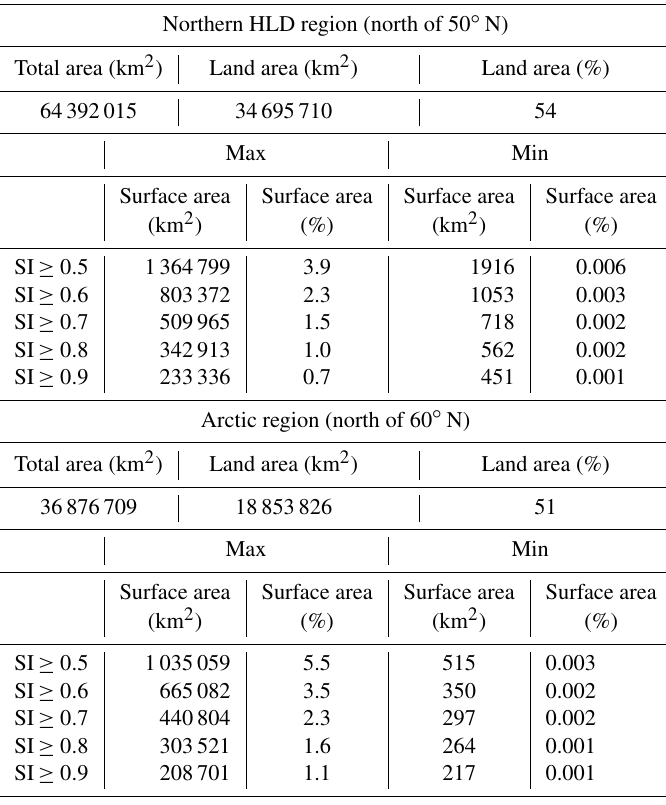
Table 2. Relevant surfaces for the northern HLD and Arctic regions: surface of total area of the region, surface of land area within the region (km 2 and % of the total surface), and total surface (km 2 and % of the land surface) of areas with SI values above thresholds (0.5 for surfaces with at least “higher” dust emission potential, 0.7 for surfaces with at least “high” dust emission potential, and 0.9 for surfaces with the “highest” dust emission potential) in maximum (max) and minimum (min) seasonal values; values are derived from UNCCD G-SDS-SBM.